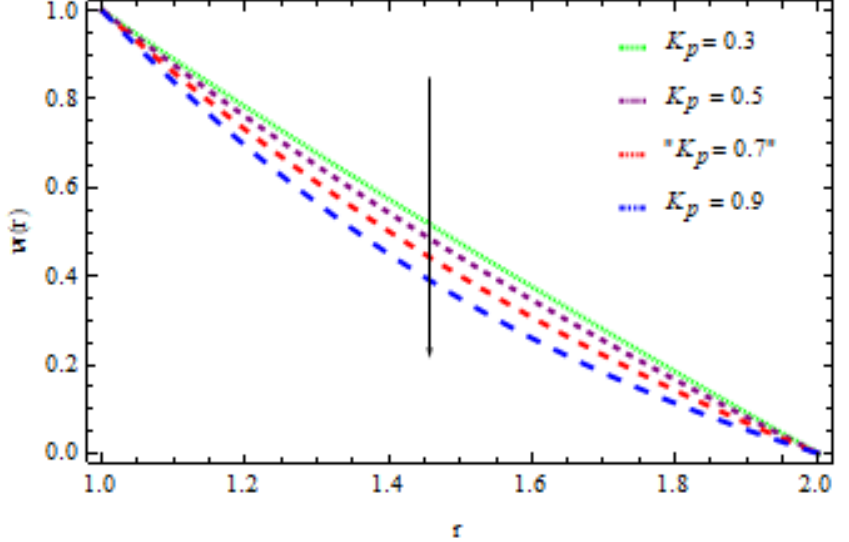
Figure 3. The influence of K p on velocity distribution in Reynolds’ model (RM) when Q = 0.2, M = 0.5, ε = 0.6, N = 0.1, m = 0.4, β 0 = 0.1, B r = 0.2,